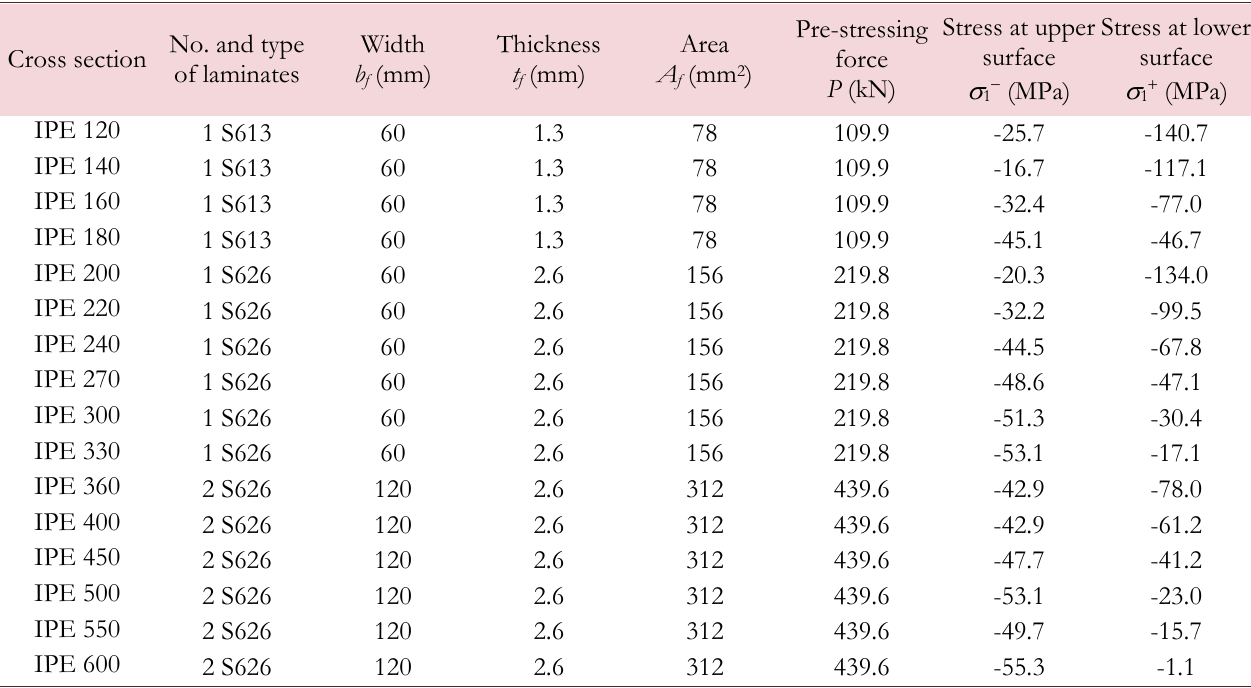
Table 3: Pre-stressing of FRP